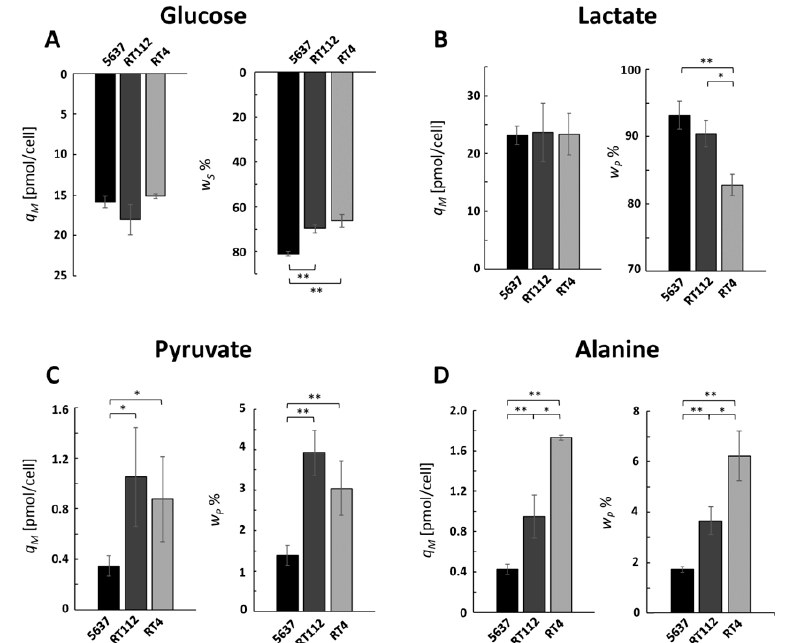
Figure 2. Variations in glucose ( A ), lactate ( B ), pyruvate ( C ), and alanine ( D ) extra-cellular concentrations observed during the third day and normalized by cell growth (left panel) and intake or excretion profile (right panel). * p < 0.05; ** p < 0.01.